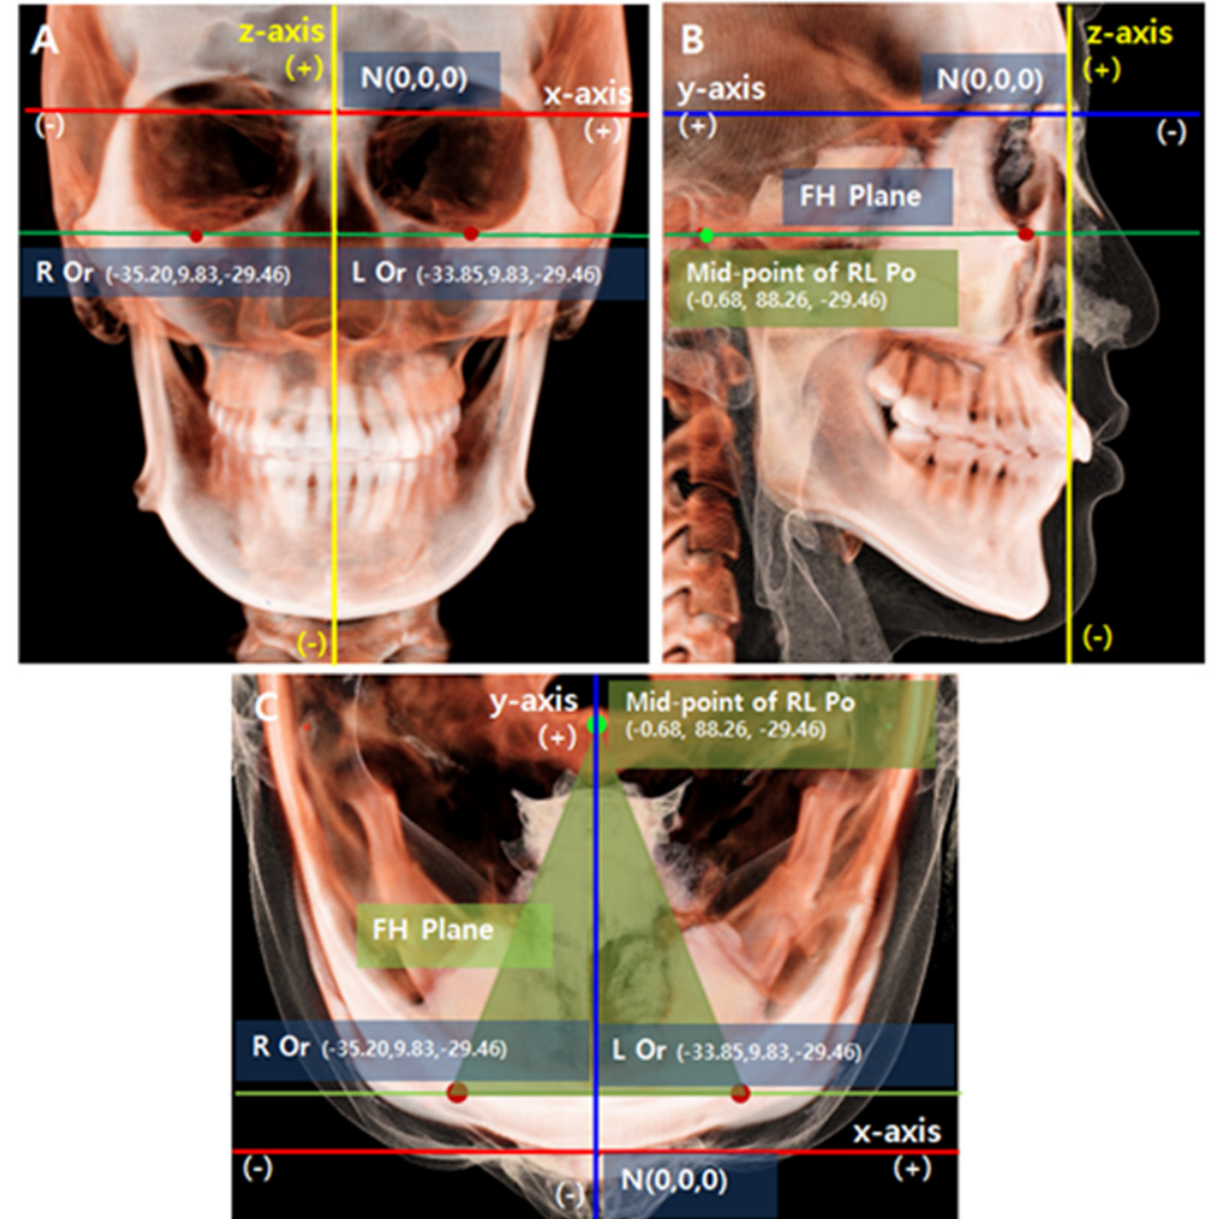
Figure 1. The coordinate system and standard reorientation of the CBCT Images. ( A ) Coronal view. ( B ) Sagittal view. ( C ) Axial view. The coordinate system consists of three axes (x, y, z) with their origin (0,0,0) registered at nasion (N). The Frankfort horizontal plane (FH plane) was constructed with bilateral orbitale (Or) points and the midpoint of bilateral porion (Po) points. The orbit line is a line passing both orbitale points in 3D space. The x-axis (red line) is a transverse axis passing through the N point and is also parallel to the FH plane in the coronal plane. The y-axis (blue line) is the anteroposterior axis passing through the N point and perpendicular to the x-axis. The y-axis is parallel to the FH plane in the sagittal plane. The z-axis (yellow line) is the vertical axis perpendicular to both the x- and y-axes. The x-axis is also parallel to the orbit line in the axial plane. Positive values are to the left, posterior, and superior (LPS) of the N point of the subject. Negative values are to the right, anterior, and inferior (RAI) of the N point. 3D landmarks were automatically digitized with manual modification, and 3D meas- urements were made to determine the facial, skeletal, and dental characteristics of the 40 subjects using ON3D software (Figures 2 and 3). Definitions of the 3D landmarks and values are described in Table 1A,B. Table 1. ( A ). Definitions of three-dimensional landmarks. ( B ) Definitions of three-dimensional values.